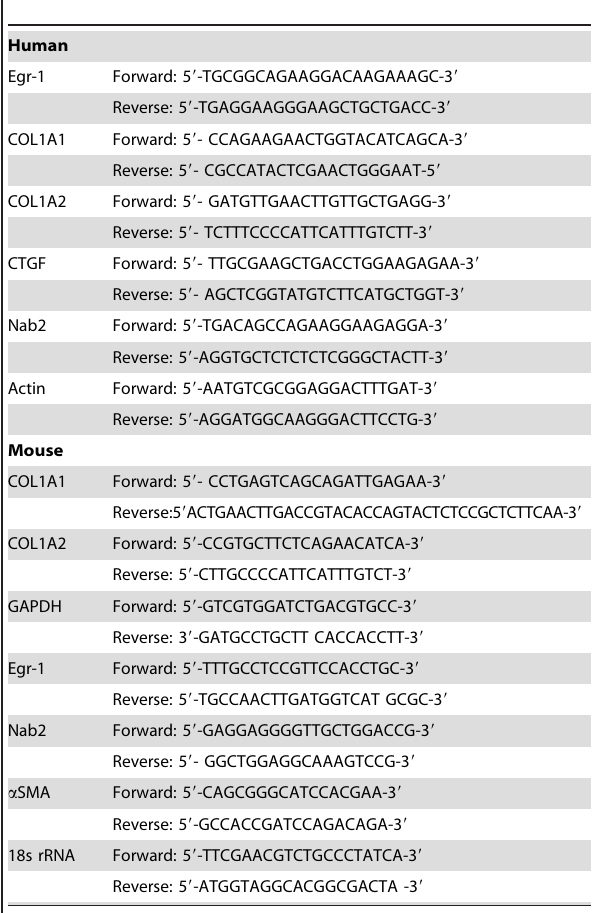
Table 1. Oligonucleotides used for Real-Time Quantitative